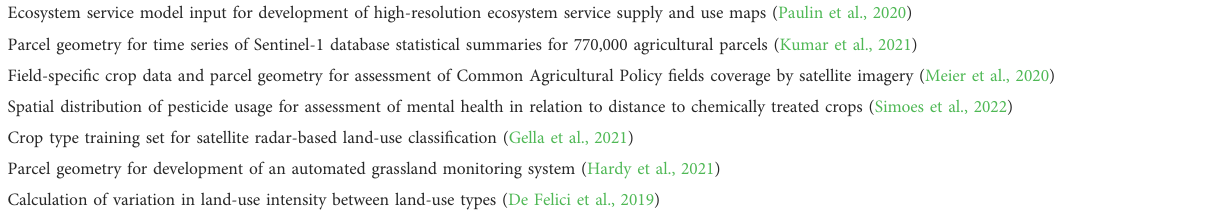
TABLE 1 Indicative table of publications that implement BRP data.